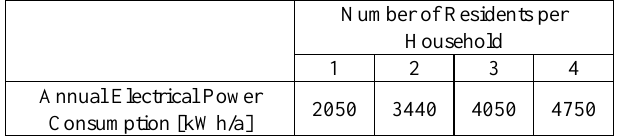
Figure 8. 3D visualisation of coloured buildings regarding the estimated annual warm water demand